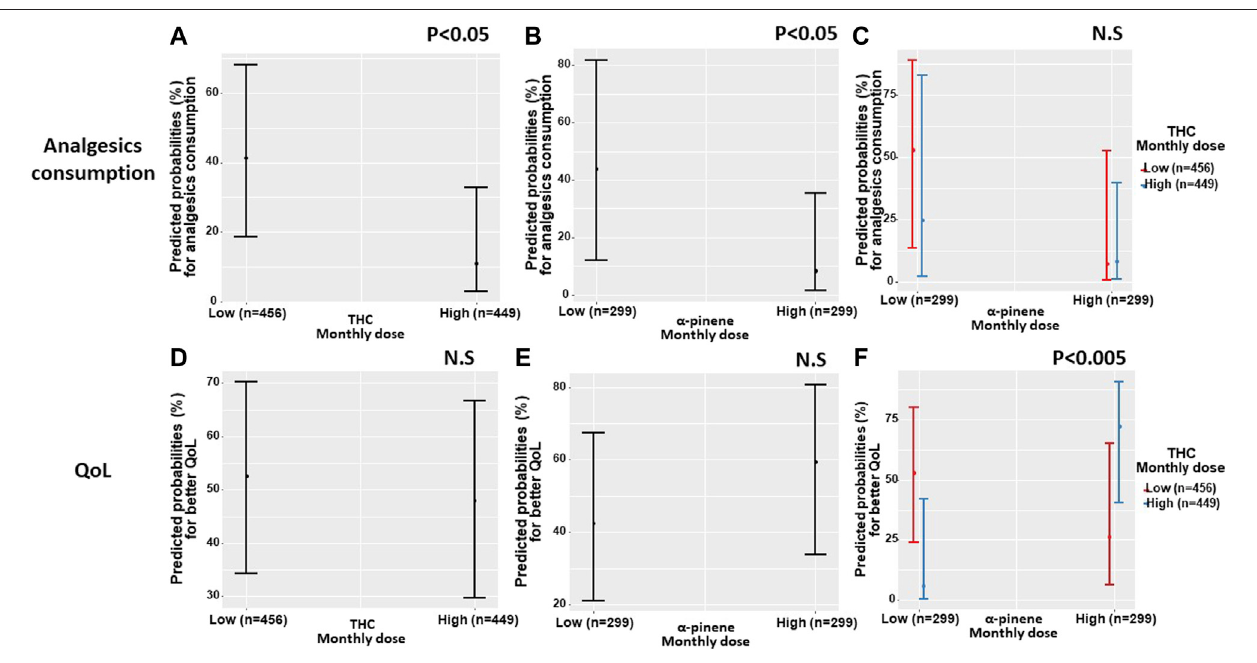
FIGURE5| Predictedprobabilitiesofanalgesicsconsumption andquality oflifebyTHC and α -pinene dosethepredictedprobabilitiesoftheassociationsbetween theconsumption ofahighorlowmonthlydosesofTHCand α -pinene,separately (A,B) foranalgesicsconsumption, (D,E) for ’ better ’ qualityoflife)andbyinteraction (C) foranalgesicsconsumption, (F) for ’ better ’ qualityoflife).QoL,qualityoflife;THC, Δ 9-trans-tetrahydrocannabinol;Low THCmonthlydoserefersto123 – 4,892 mg,high THC monthly dose refers to 4,892 – 14,123 mg; Low α -Pinene monthly dose refers to 3,211 – 23,413 parts per million (PPM), high α -Pinene monthly dose refers to 23,413 – 471,725